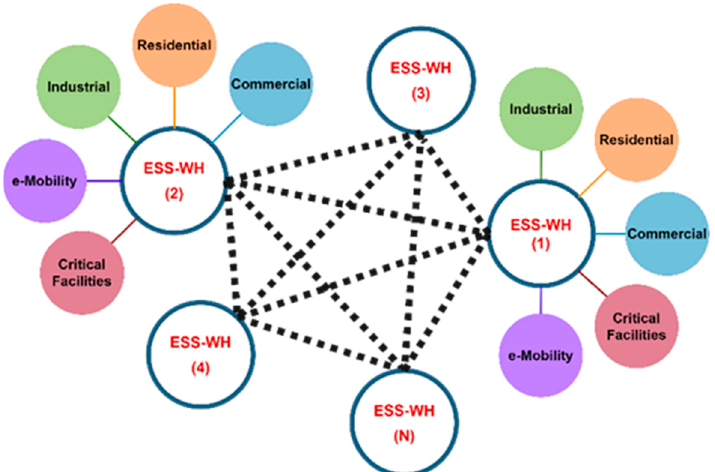
Figure 1. A conceptual description of the networked energy storage systems model. ESS-WHs house a number of MoBESSs. Each ESS-WH provides a cluster of services and is connected to other ESS-WHs through the road network (dashed lines). Electric trucks ship MoBESSs from an ESS-WH to its demand locations or the neighboring ESS-WHs. The network of ESS-WHs thus becomes an off-grid power system, the resiliency of which is the subject of this study.